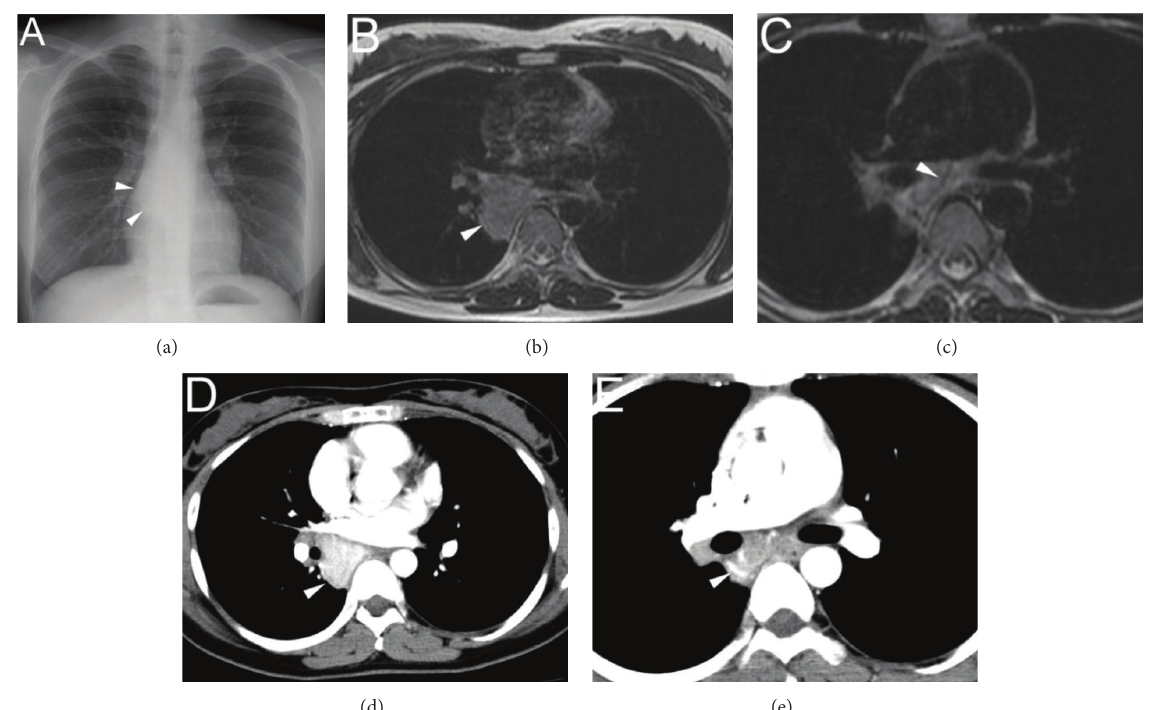
Figure 1: (a) Chest X-ray image showed a mass shadow in the cardiac silhouette obscuring the azygoesophageal line (arrowhead). (b) and (c) Magnetic resonance imaging (MRI) revealed a mass in the subcarinal azygoesophageal recess. The mass was hyperintense on T2-weighted images (arrowhead) (b). Flow voids (arrowhead) were detected within the mass (c). (d) and (e): On contrast-enhanced computed tomography (CT) scan, the mass was enhanced homogeneously and intensely (arrowhead) (d), and enlarged vessels were detected just cephalad to the tumor (arrowhead)